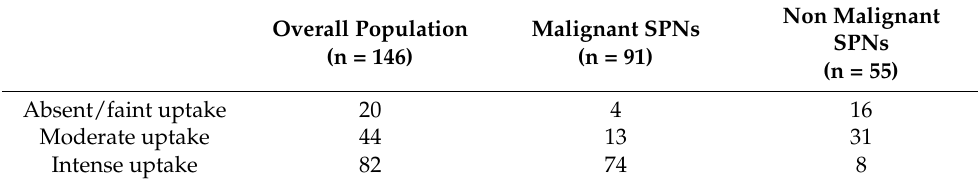
Table 3. Visual analysis results for solitary pulmonary nodules (SPNs).